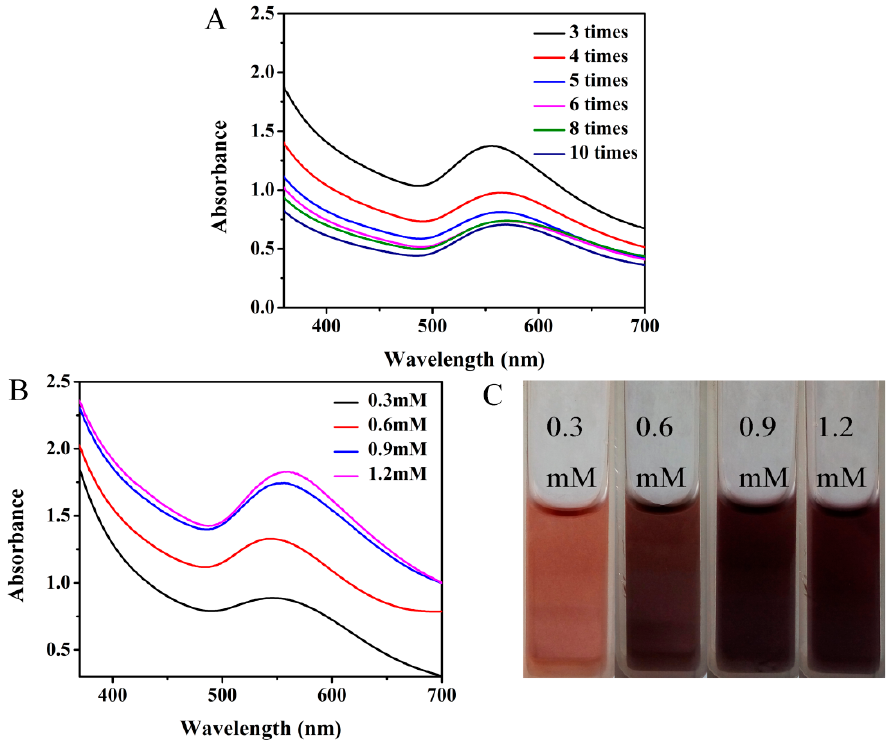
Figure 3. ( A ) UV-vis spectra of CQDs/AuNPs with different concentrations of CQDs (diluted 3 to 10 times); ( B ) UV-vis spectra and ( C ) the photographs of CQDs/AuNPs with different concentrations of HAuCl 4 (0.3 mM–1.2 mM).